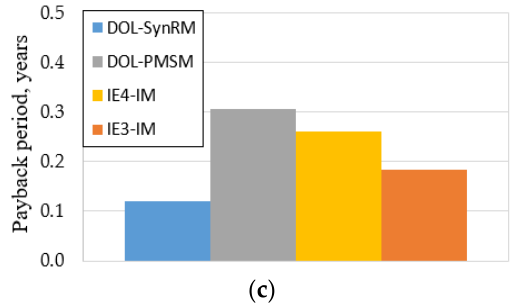
Figure 11. Payback period of various motor types (the case of a new pump unit commissioning): ( a ) case 1 (without cable and transformer losses); ( b ) case 2 (3 pump units considering the cable loss) ( c ) case 3 (3 pump units considering the cable and transformer losses).